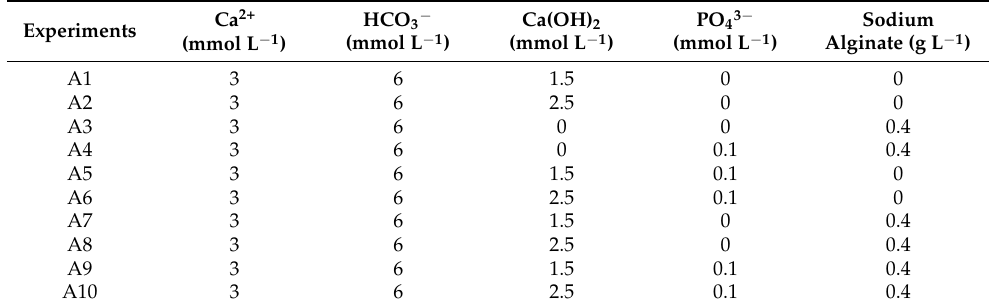
Table 1. Jar tests softening